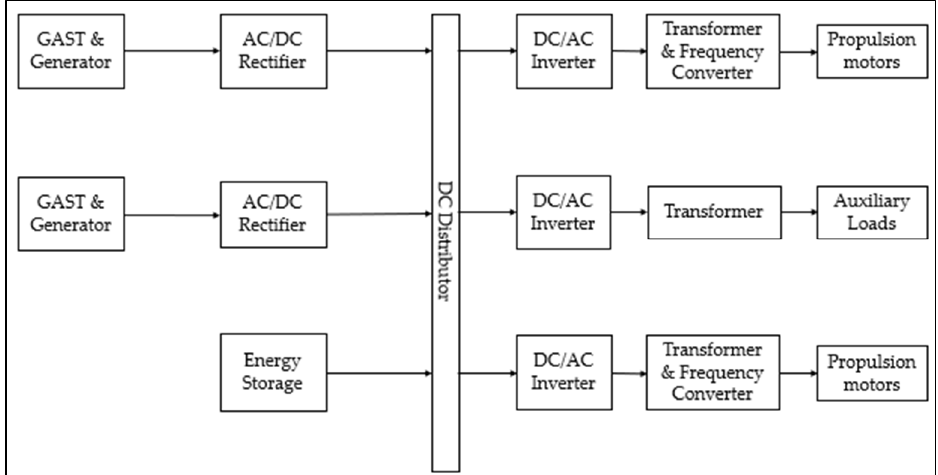
Figure 5. Simplified power flow of hybrid LNG–electric vessel power systems.